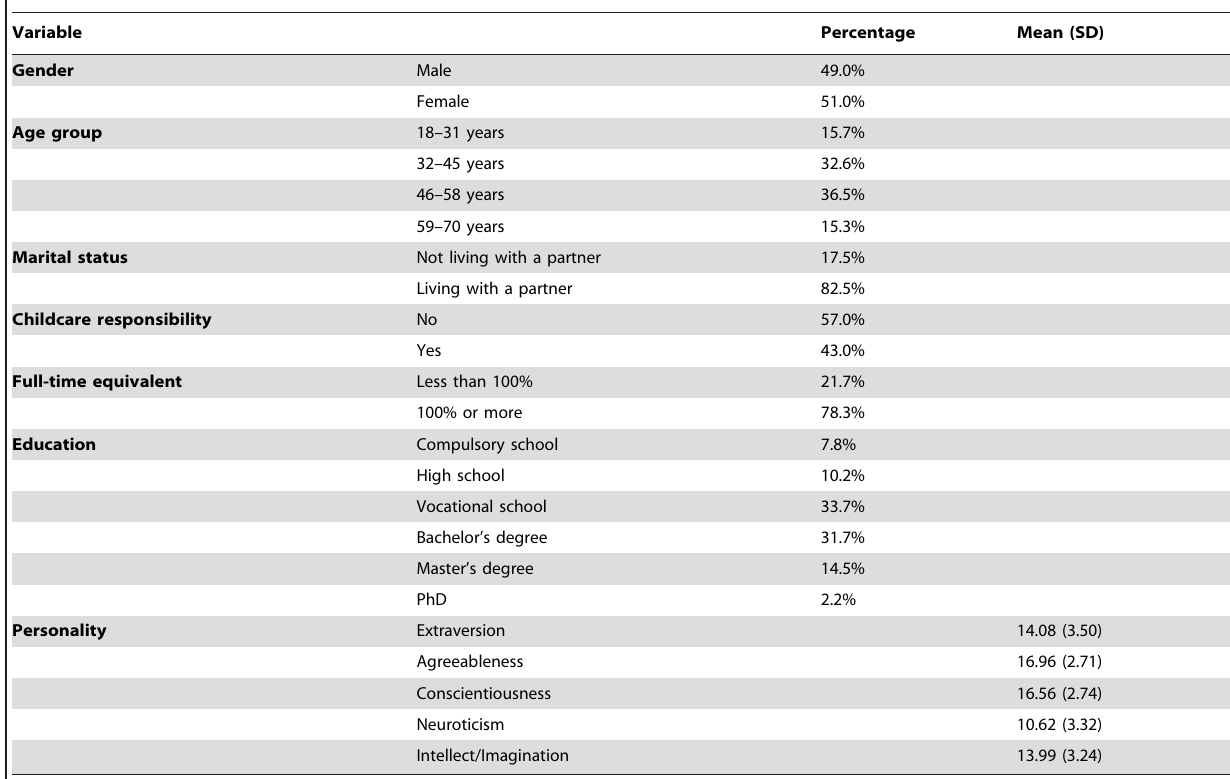
Table 1. Descriptive data for the sample (N =1,124).